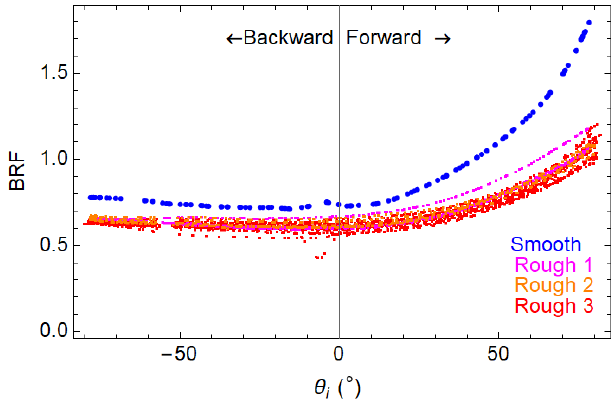
Figure 14. Measured principal plane BRFs in Mantovaaranaapa on 22 April 2009 of one smooth snow and three rough snow cases, with a few individual profiles each.